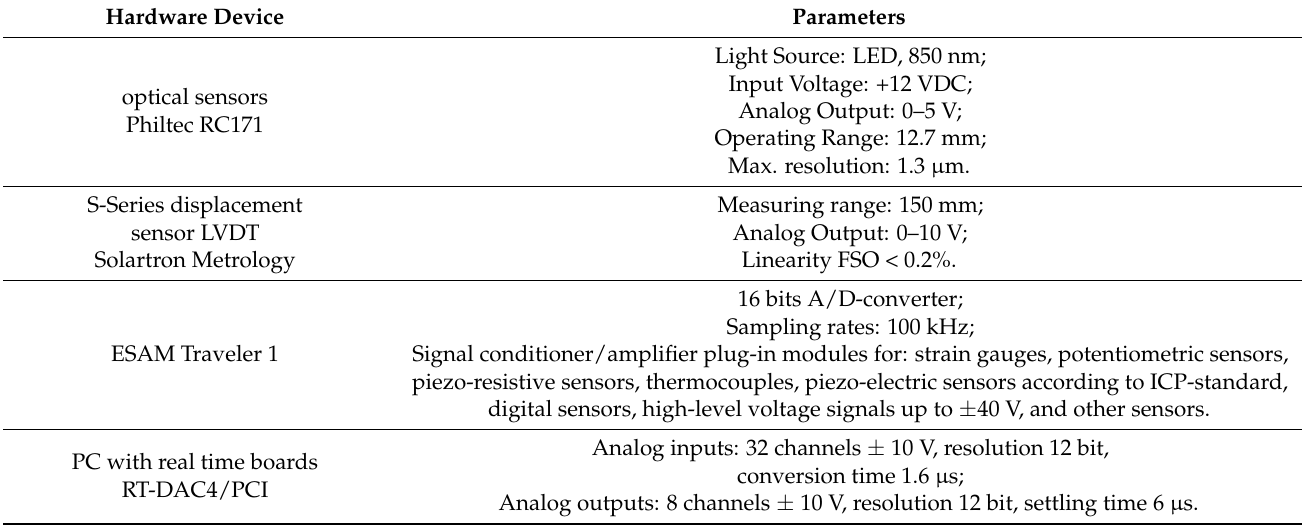
Table 1. Technical specifications of the Rotacaster 125 mm omnidirectional